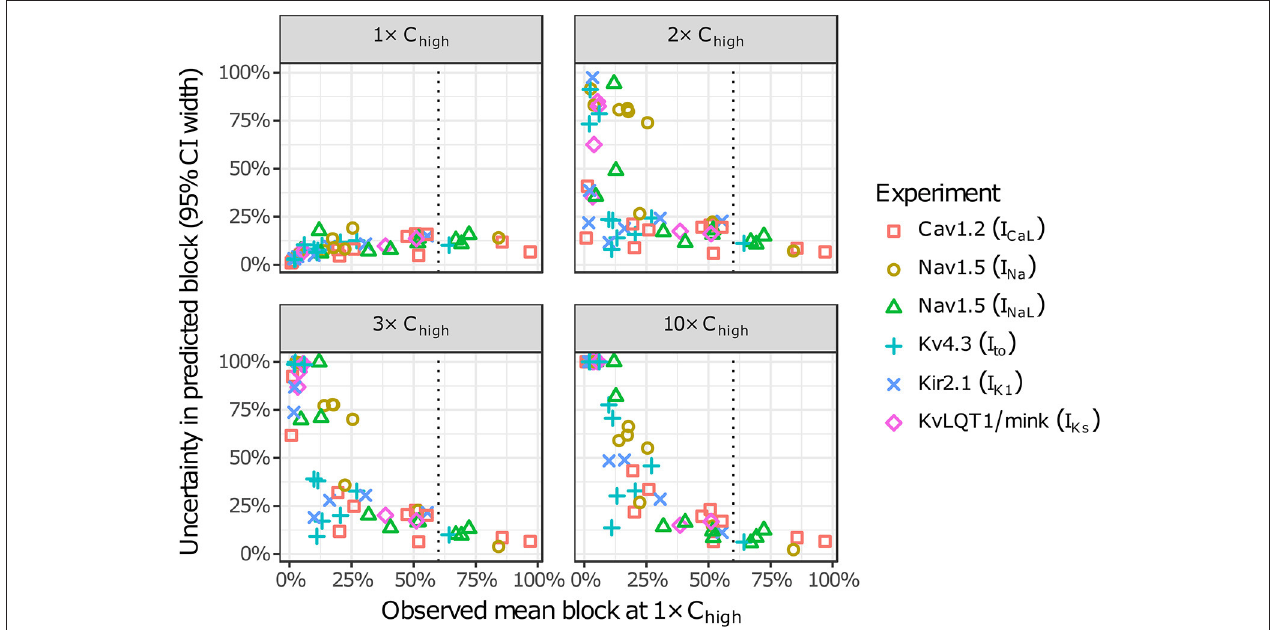
FIGURE 4 | Uncertainty in dose-response curves at extrapolated drug concentrations. Current block experiments were performed for six ionic currents (see legend) with the 12 CiPA training drugs (72 drug-current combinations total with 19 excluded, see Table 3 ). Dose-response curves were fitted for each experiment and extrapolated above the highest experimentally tested drug concentration (C high ). Uncertainty in dose-response curves was quantified at 1 × , 2 × , 3 × , and 10 × C high as the width of the 95% CI for the predicted percentage block, plotted as a function of the mean experimentally observed block at 1 × C high . Vertical dotted line is drawn at 60% observed mean block, denoting an approximate lower limit on the mean block that was observed at 1 × C high in experiments for which uncertainty remained low ( < 16%) at higher